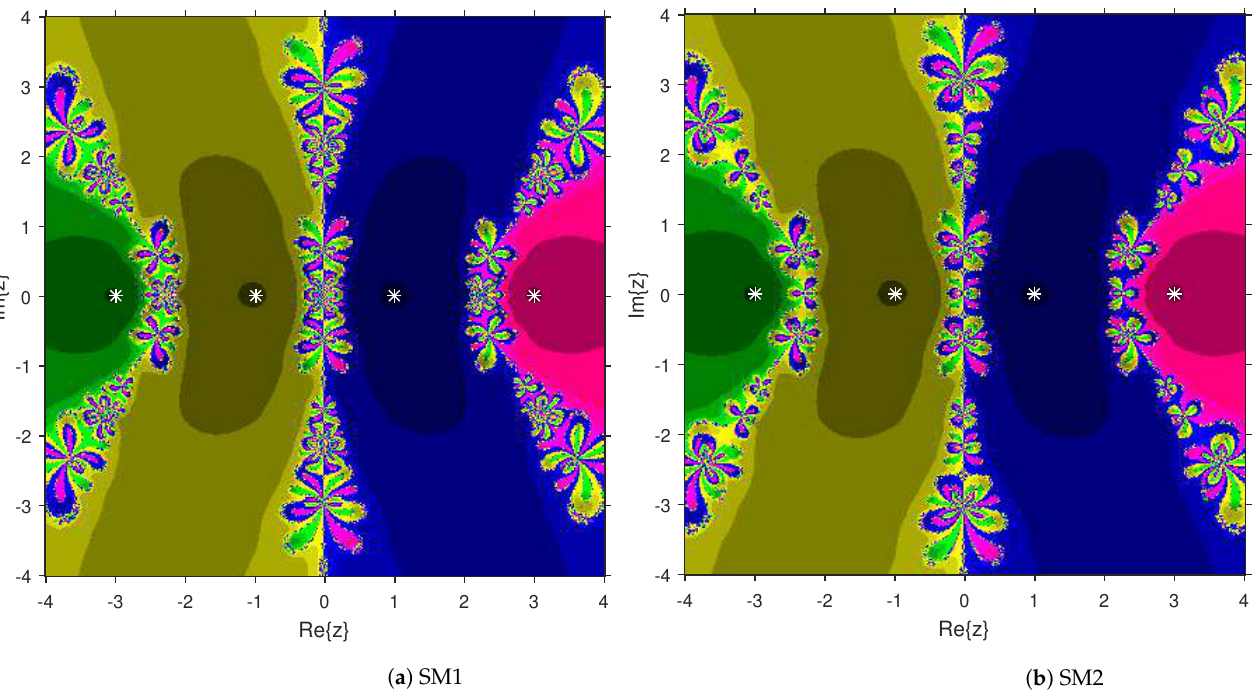
Figure 6. Attraction basins comparison between SM1 and SM2 corresponding to M 6 ( z )